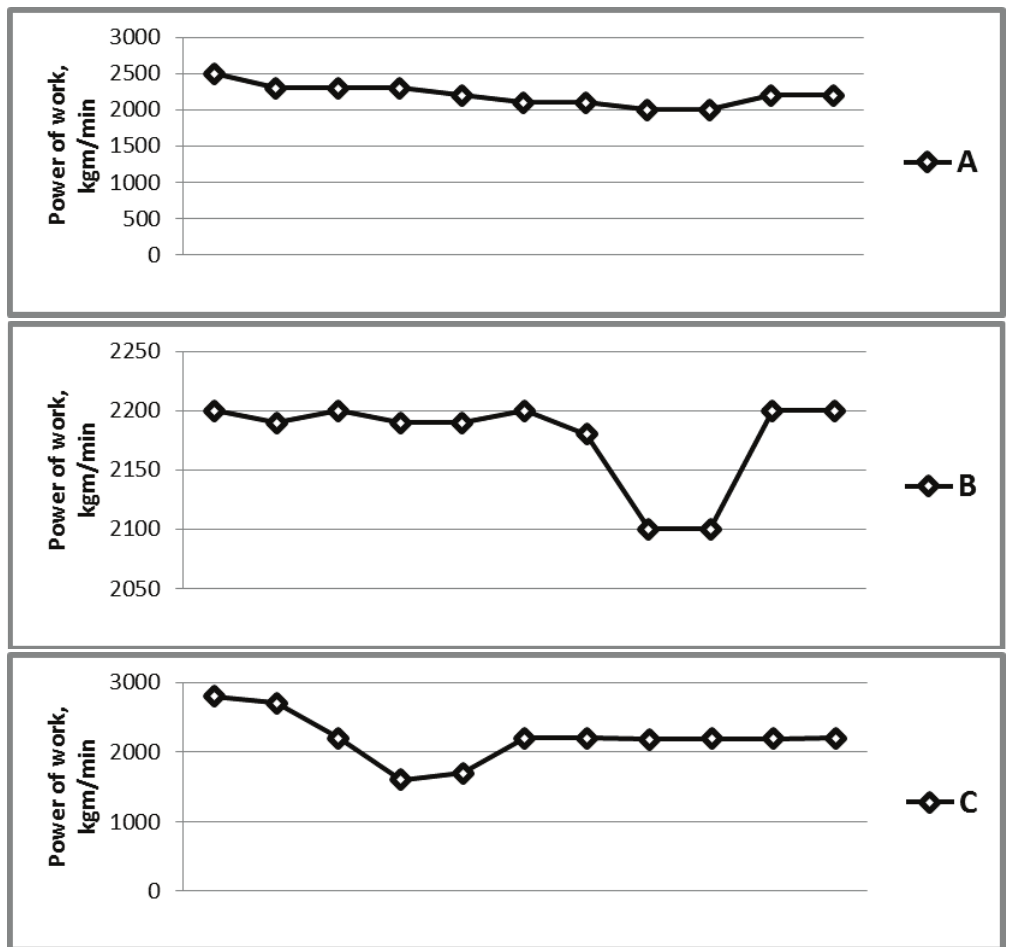
Fig. 1. Distribution of the actual pedal power at 30-second intervals: A — free test; B — fixed power test; C — test with intensive